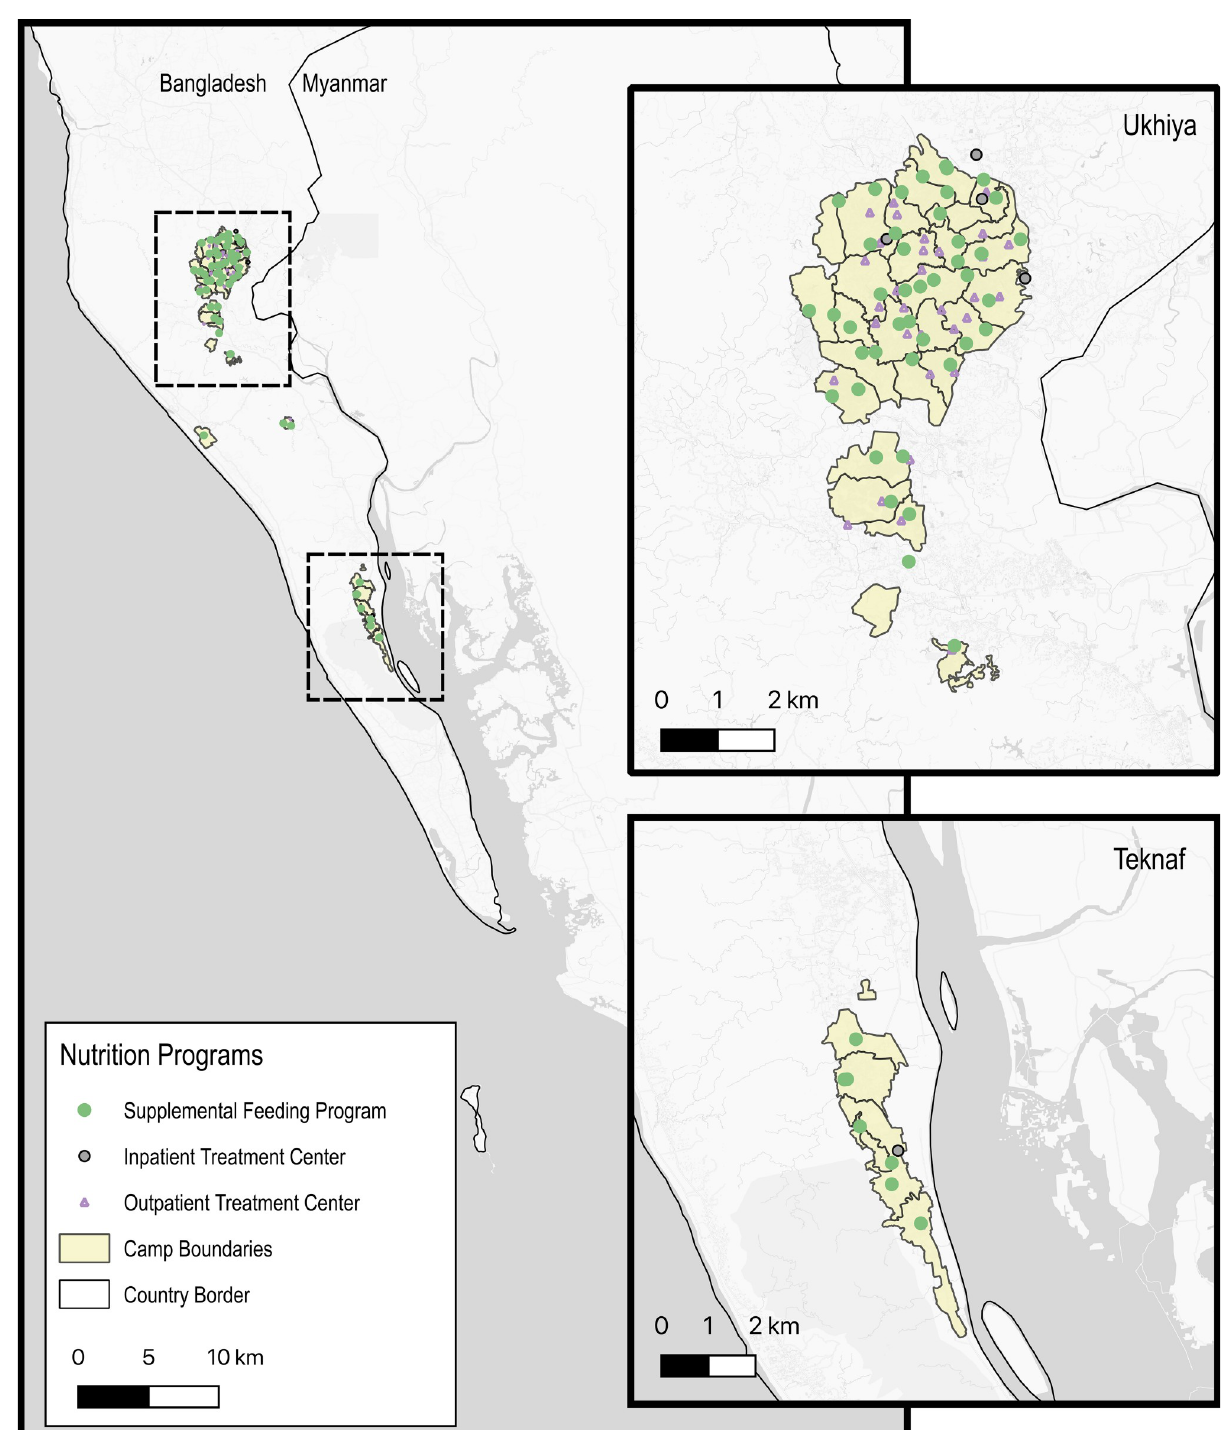
Fig 1. Map of nutrition centres in the makeshift settlements. Location of nutrition programmes in makeshift settlements of Cox’s Bazar, Bangladesh as of August 2018. Base maps including refugee camp boundaries obtained from the Humanitarian Data Exchange.